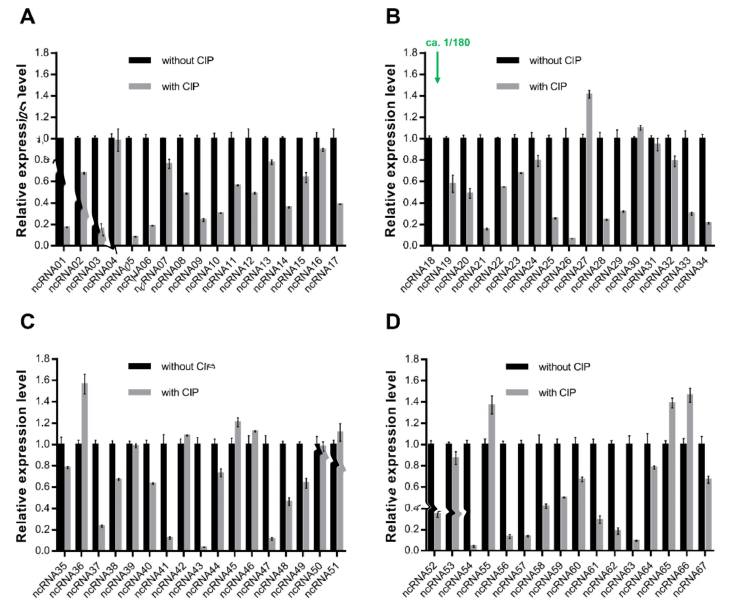
Figure 1. ( A – D ) Relative mRNA expression levels of 67 ncRNAs with the presence or absence of ciprofloxacin treatment. Expression data were obtained from three independent repeated tests ( n =